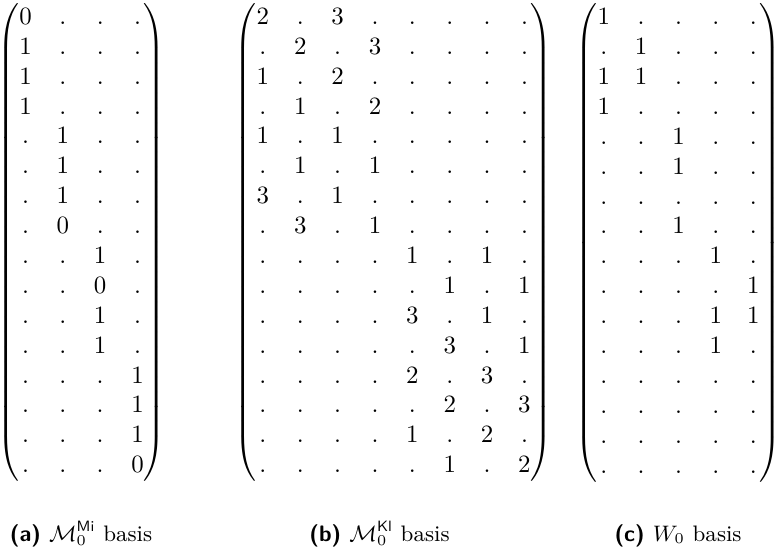
Figure 2: Compatibility basis representations for Midori (left) and Klein